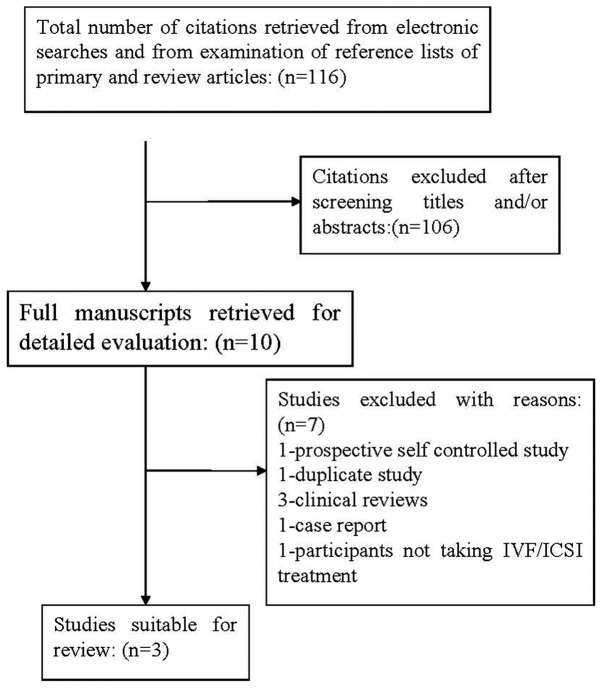
Flow chart of study selection. IVF/ICSI, in vitro fertilization/intracytoplasmic sperm injection.